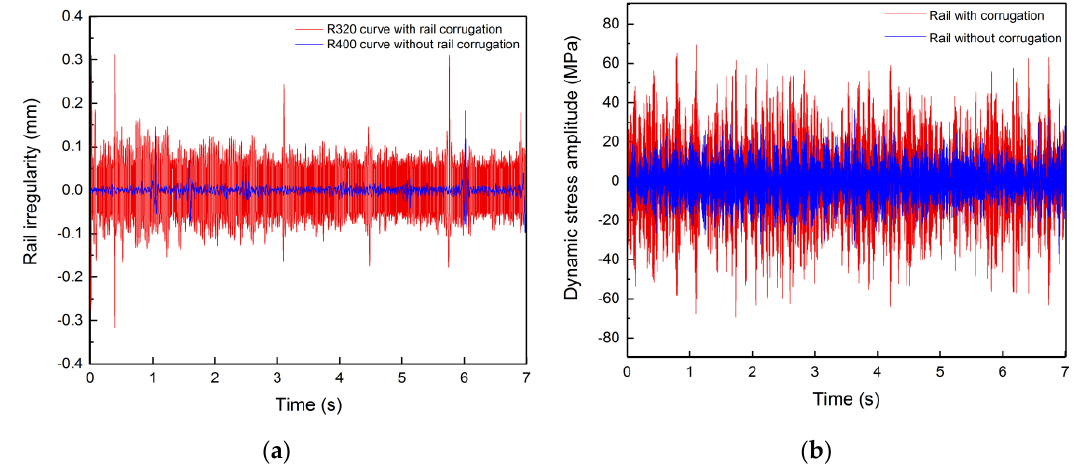
Figure 17. The relationship between rail irregularity and the dynamic stress amplitude: ( a ) degree of rail irregularity; ( b ) dynamic stress.